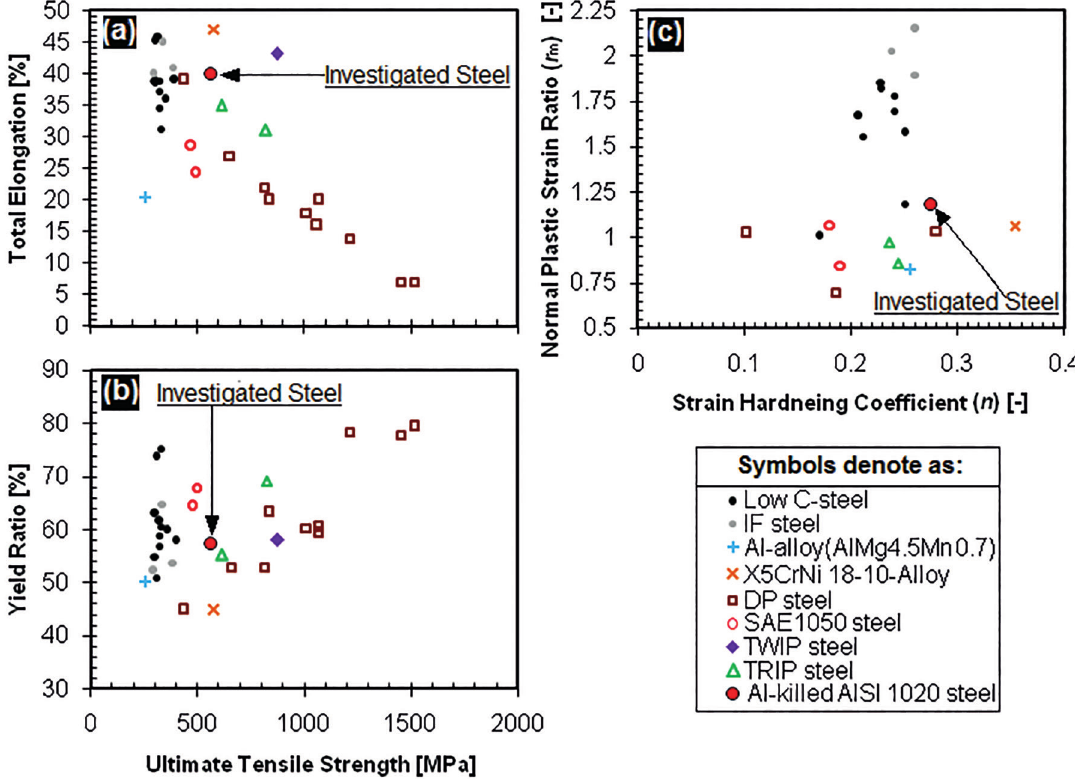
Figure 6: Comparisons of Al-killed AISI 1020 steel with conventional sheet metals (obtained from literatures) with respect to, (a) TEl. vs. UTS ; (b) YR vs. UTS ; (c) r vs. n m